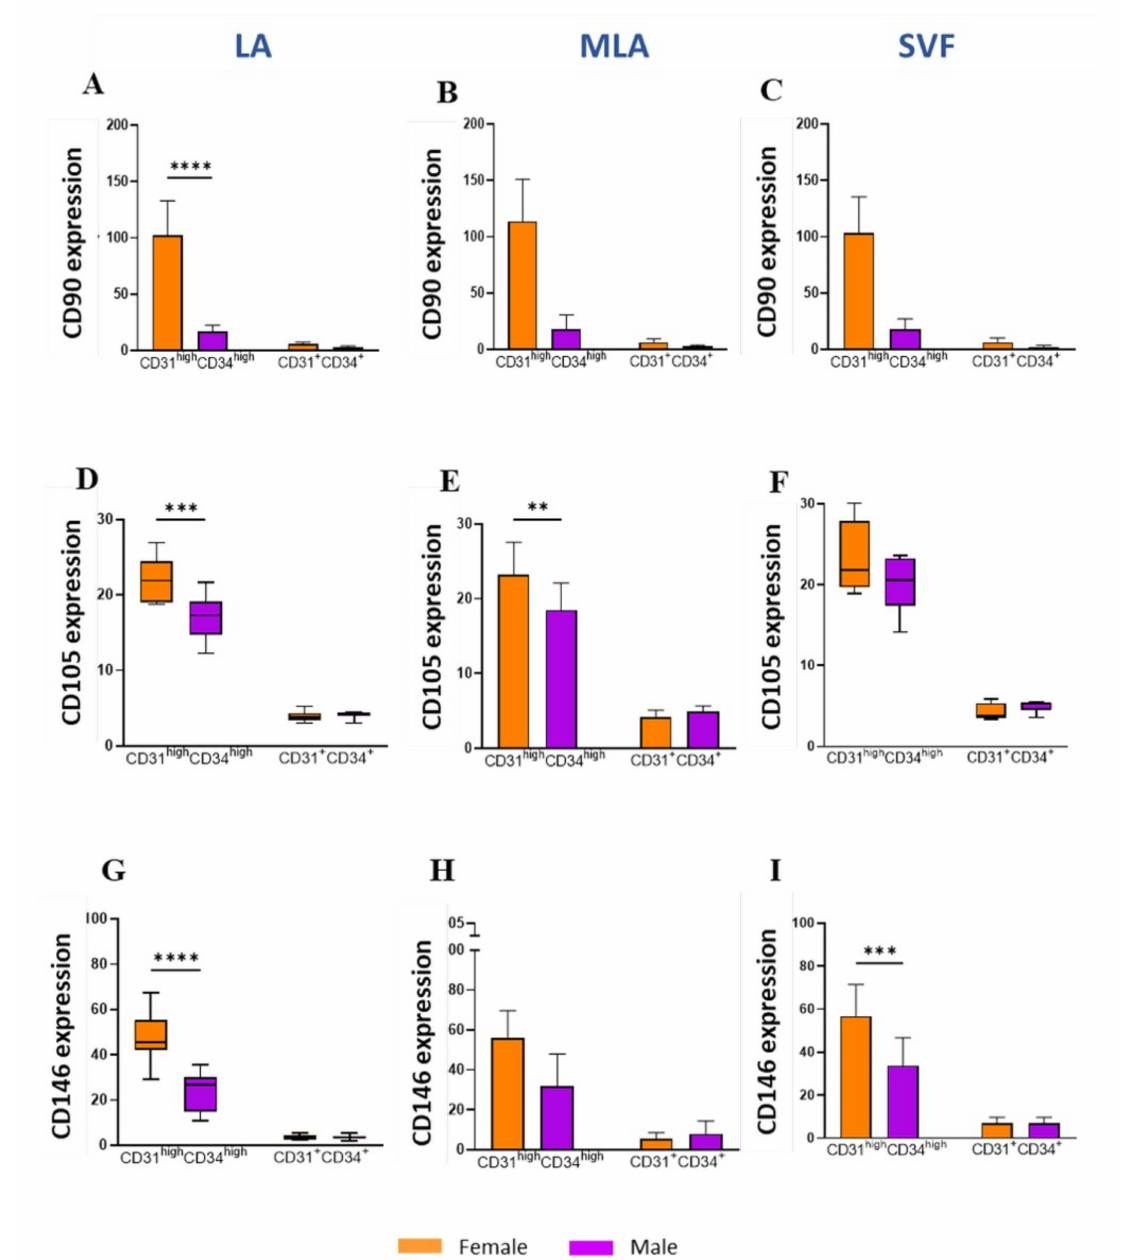
Figure 6. Expression of the mesenchymal stem/stromal cell-characteristic markers in EP subpopulations. Differ- ences between female and male patients in the expression of CD90 ( A – C ), CD105 ( D – F) and CD146 ( G – I ) markers on CD31 high CD34 high EP and CD31 + CD34 + EP from LA (left panels), MLA (middle panels) and SVF samples (right panels). The geometric mean fluorescence intensity (geo MFI) data are expressed as bars with SD ( A – C , E , H , I ) or box and whiskers ( D , F , G ) of 8 patients. Statistical analysis was performed using ordinary one–way ANOVA with Sidak’s multiple comparison test ( A – C , E , H , I ) or Kruskal–Wallis with Dunn’s multiple comparisons test ( D , F , G ). p -values: (**) p < 0.01; (***) p < 0.001; (****) p <